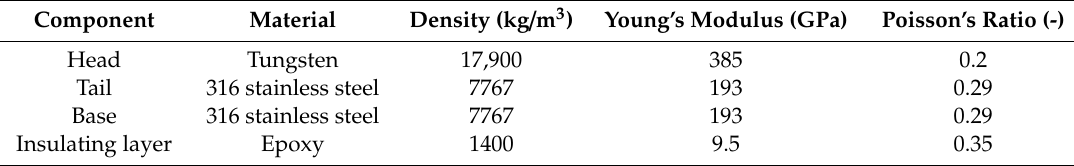
Table 1. Component materials and their mechanical properties (density, Young’s modulus, and Poisson’s ratio).